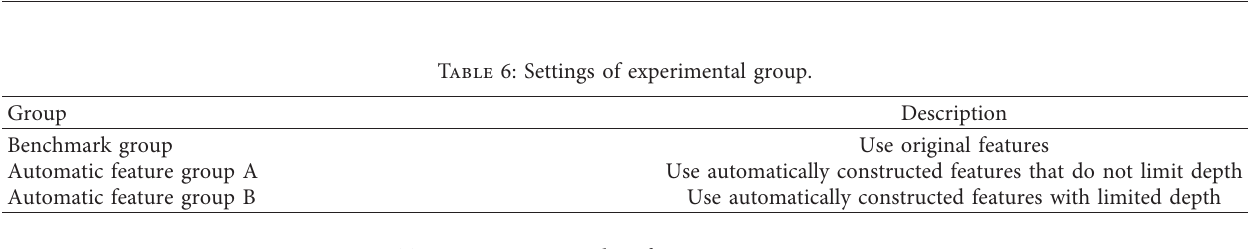
Table 7: Experimental performance comparison.